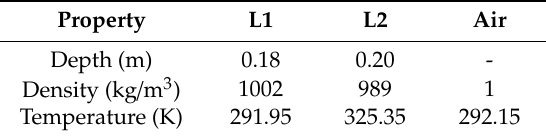
Table 1. Depth, density, and temperature values of L1, L2, and air.